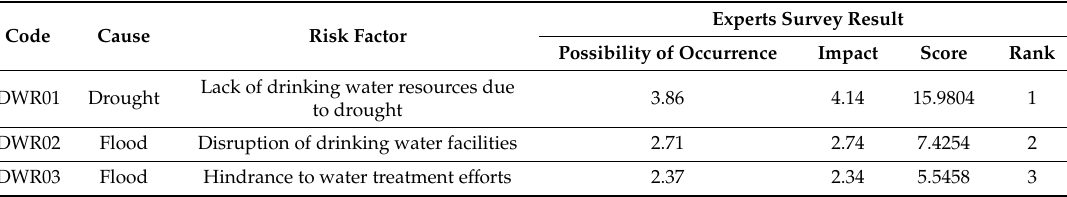
Table A1. DWR risk factors and assessment result of